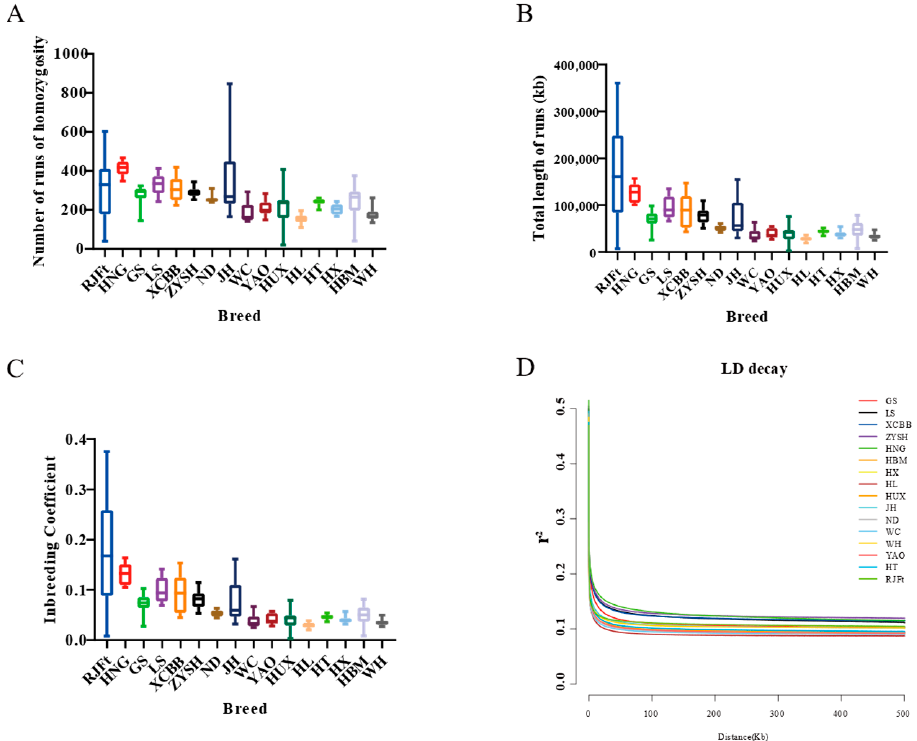
Figure 2. Runs of homozygosity and linkage disequilibrium of different indigenous chicken breeds and red jungle fowl. ( A – C ) Statistical for runs of homozygosity and genomic inbreeding coefficient of different breeds. ( D ) Decay of linkage disequilibrium in the 16 chicken populations. Linkage disequilibrium (LD) decay patterns can provide details about a population’s evolution. As a result, comparing the rate of LD decay between populations might provide useful information about the overall variety of a species. The results showed that the decay rate of Henan indigenous chickens was slower, indicating that these populations had experienced stronger selection comparing to other populations. Not surprisingly, HNG chickens showed the slowest rate of LD decay, suggesting that the breed could have been subjected to intense artificial selection during domestication (Figure